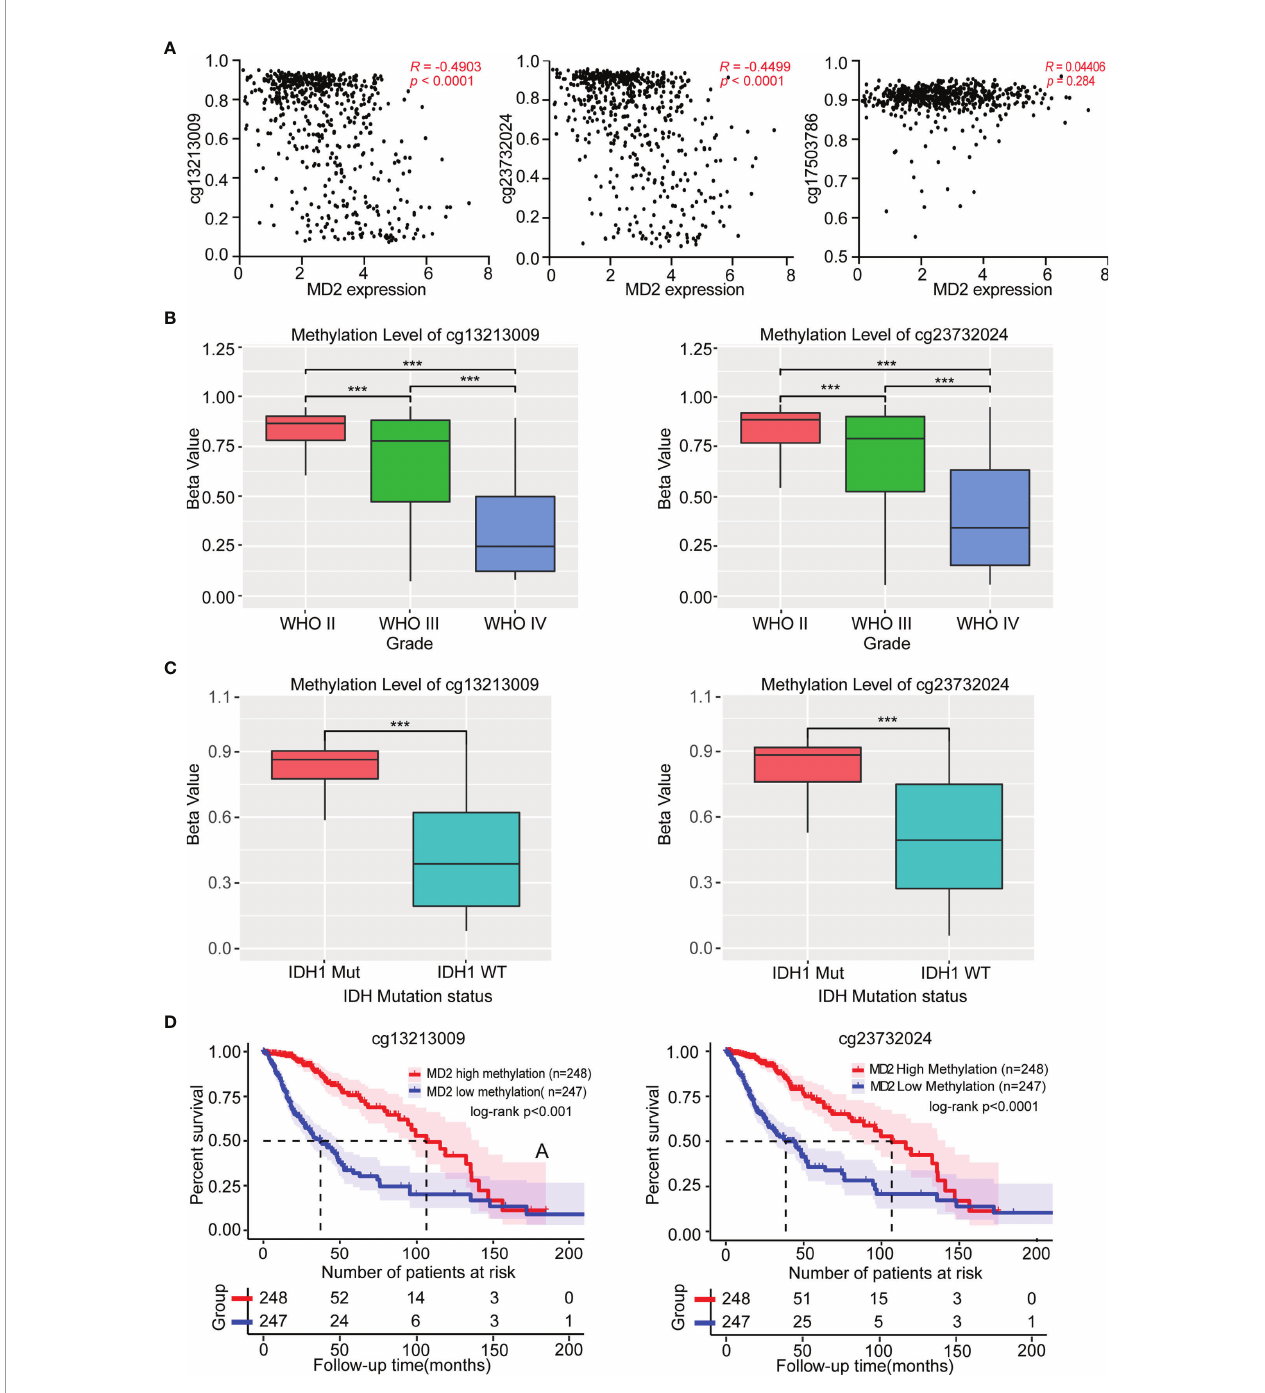
FIGURE 3 | The association between MD2 methylation and clinicopathologic characteristics. (A) The correlation between MD2 expression level and its DNA methylation at cg13213009, cg23732024 and cg17503786 CpG sites. (B) The relationship of MD2 DNA methylation level at cg13213009 or cg23732024 CpG sites with WHO grade. (C) The association of MD2 DNA methylation level at cg13213009 or cg23732024 CpG sites with IDH status. (D) Kaplan-Meier curves of low and high MD2 DNA methylation at cg13213009 or cg23732024 CpG sites. WT, Wildtype; Mut, Mutant. *** indicates p <